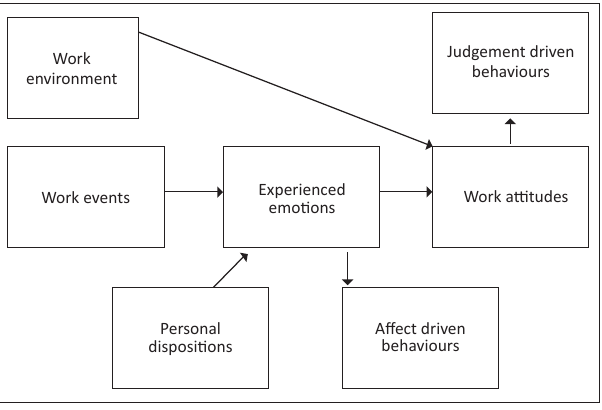
FIGURE 1: Weiss and Cropanzano’s Affective Events Theory.